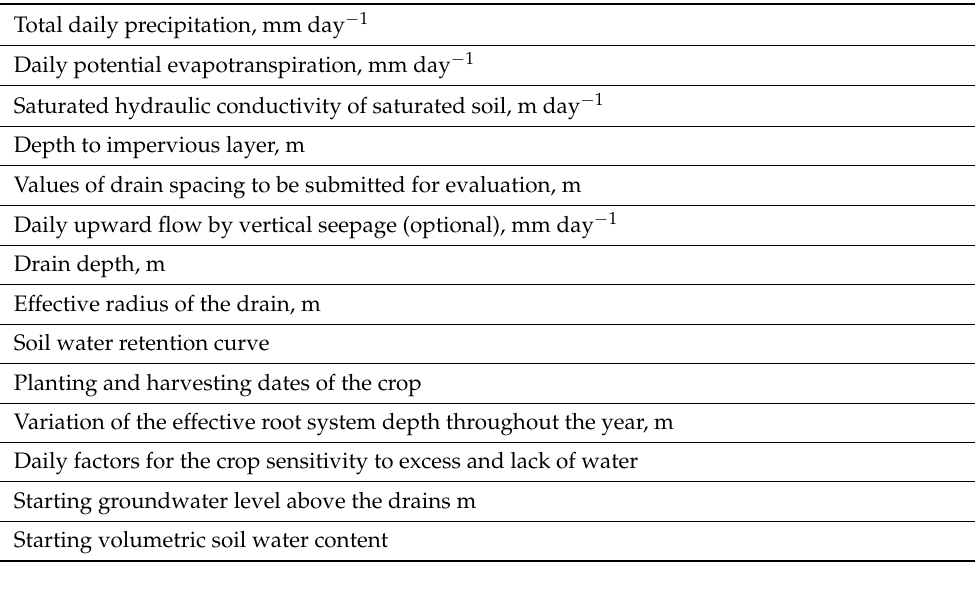
Table 1. SISDRENA input parameters.